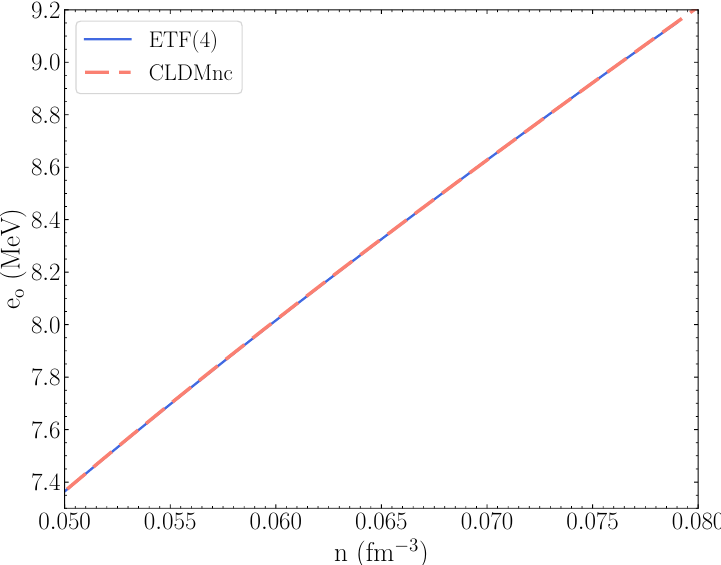
Figure 4. Energy per nucleon without neutron mass for spheres as a function of baryon number density in the ETF model (blue solid line) and in the CLDMnc model (red dashed).